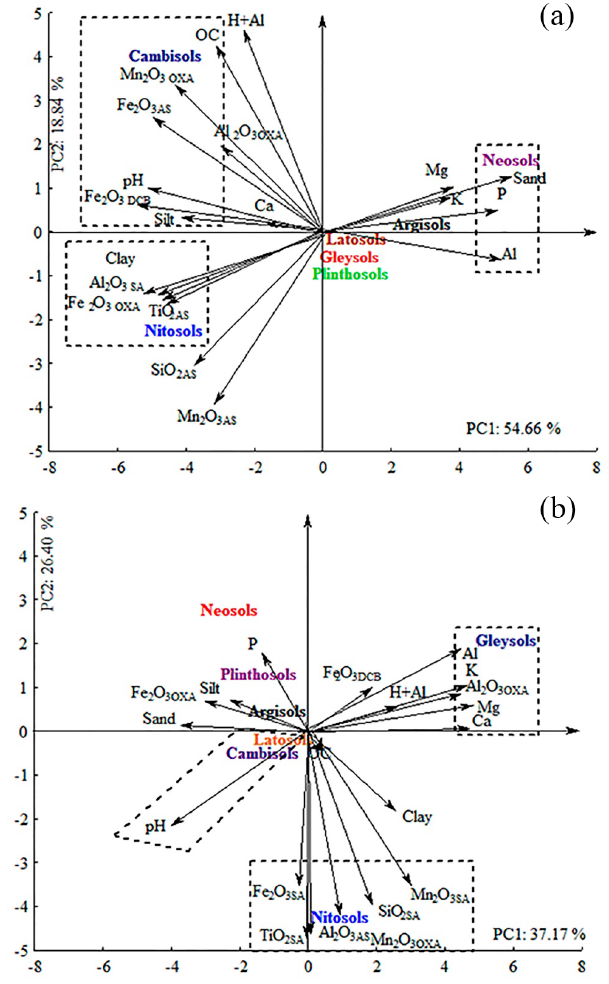
Figure 11. Principal component analysis (PC1 and PC2) of the physical, chemical, and mineralogical attributes of the samples from the surface layers (0–0.2m) (a) and the subsurface layers – diagnos- tic horizon (b) of the soils of the state of